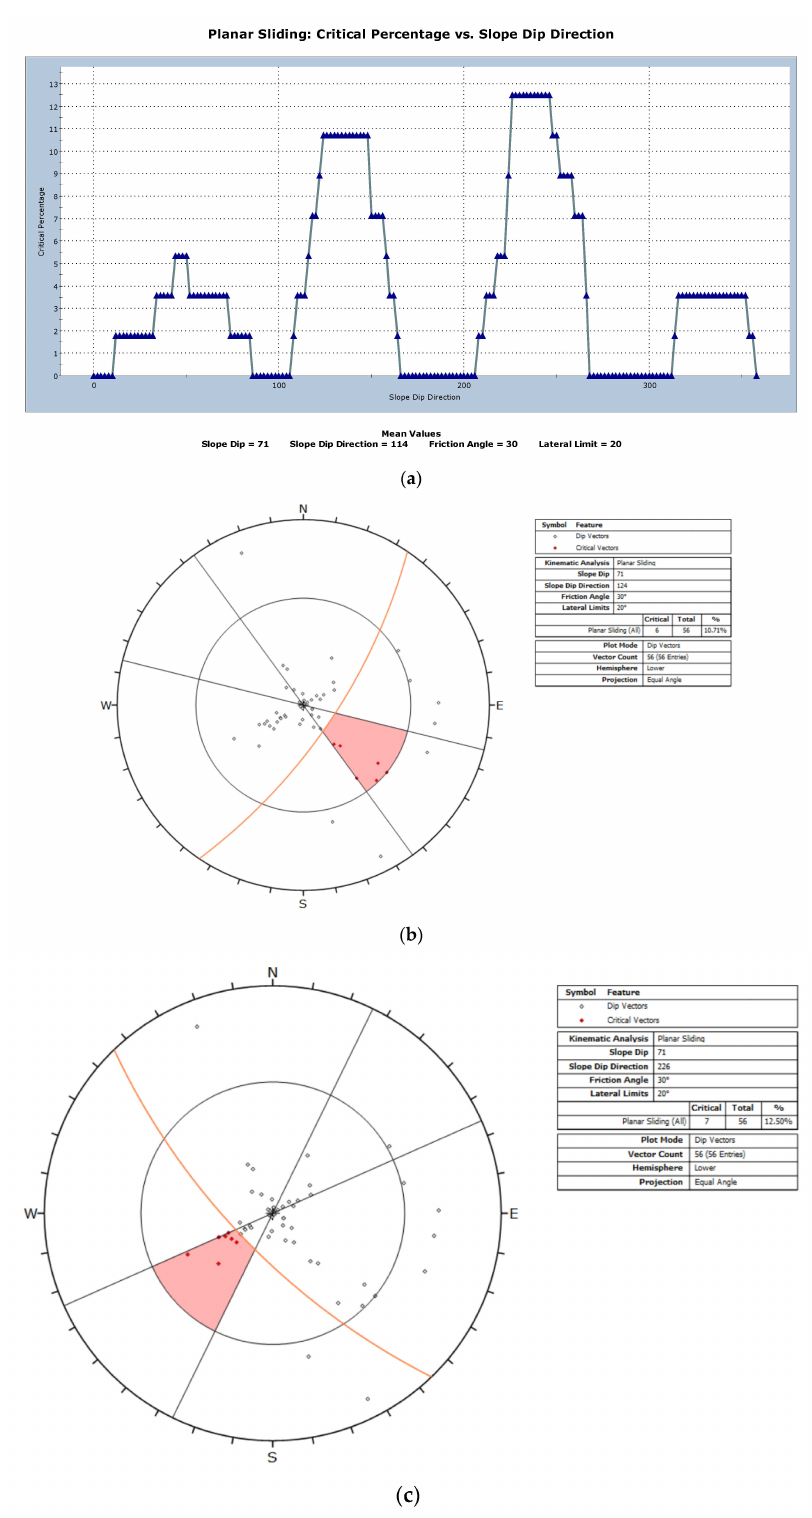
Figure 5. ( a ) Results of sensitivity analysis of kinematic conditions for planar sliding, exhibiting the variation of percentage of critical dip vectors with respect to the slope dip direction, and stereonet projection of dip vectors, highlighting the critical dip vectors for slope dip direction ( b ) 124 ◦ –144 ◦ and ( c ) 226 ◦ –246 ◦